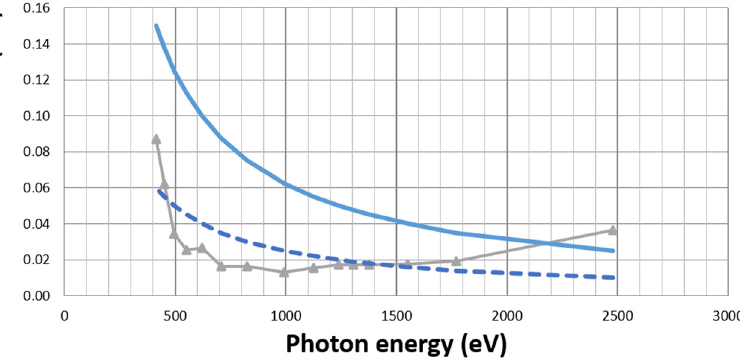
Figure 3. Simulation of wavefront errors (line with triangles) as a function of photon energy for a soft X-ray wavefront sensor design. The blue line corresponds to a wavefront error of λ /20 RMS, while the dashed blue line corresponds to λ /50 RMS.